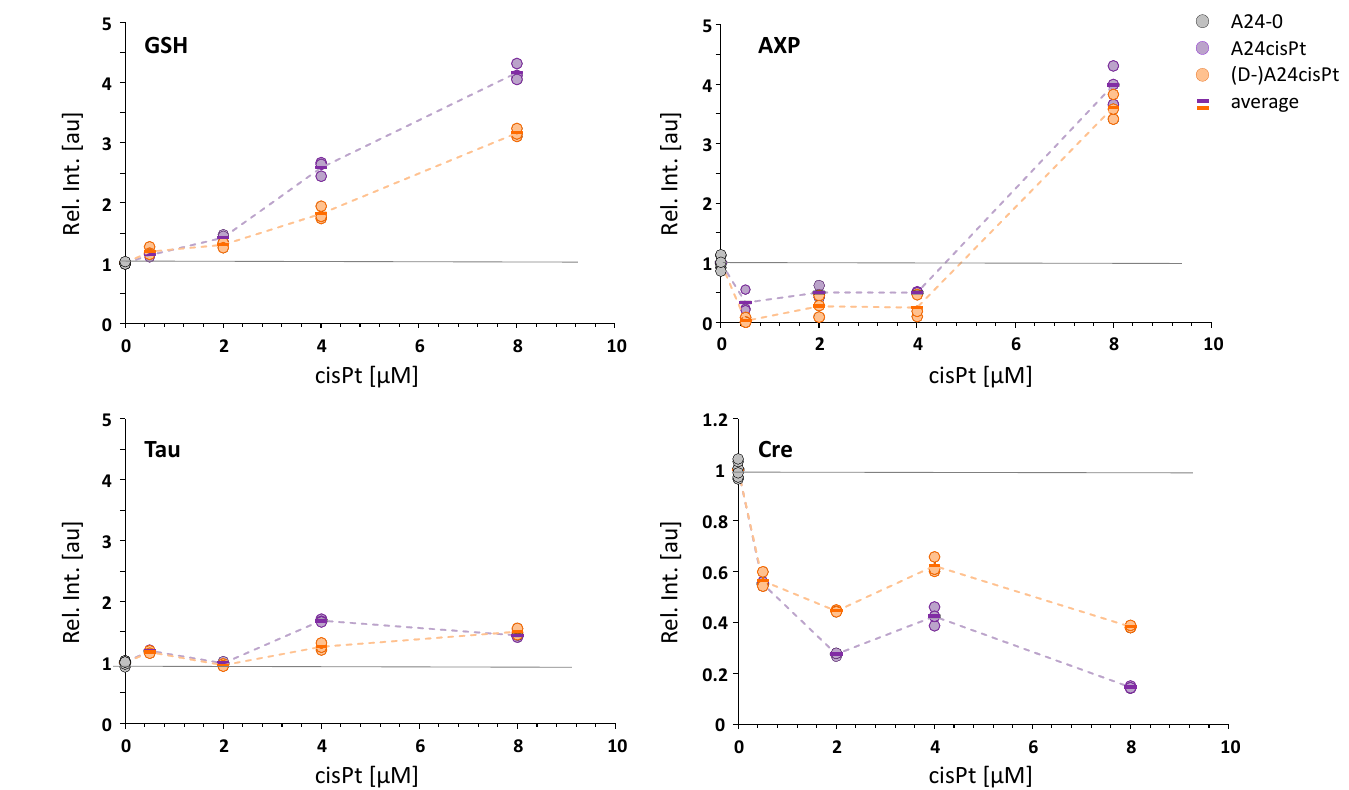
Figure 6. Metabolite levels relative to controls as function of cisPt concentration applied for resistance induction (purple: cells with induced resistance; orange: cells with resistance de-induced; gray: controls).